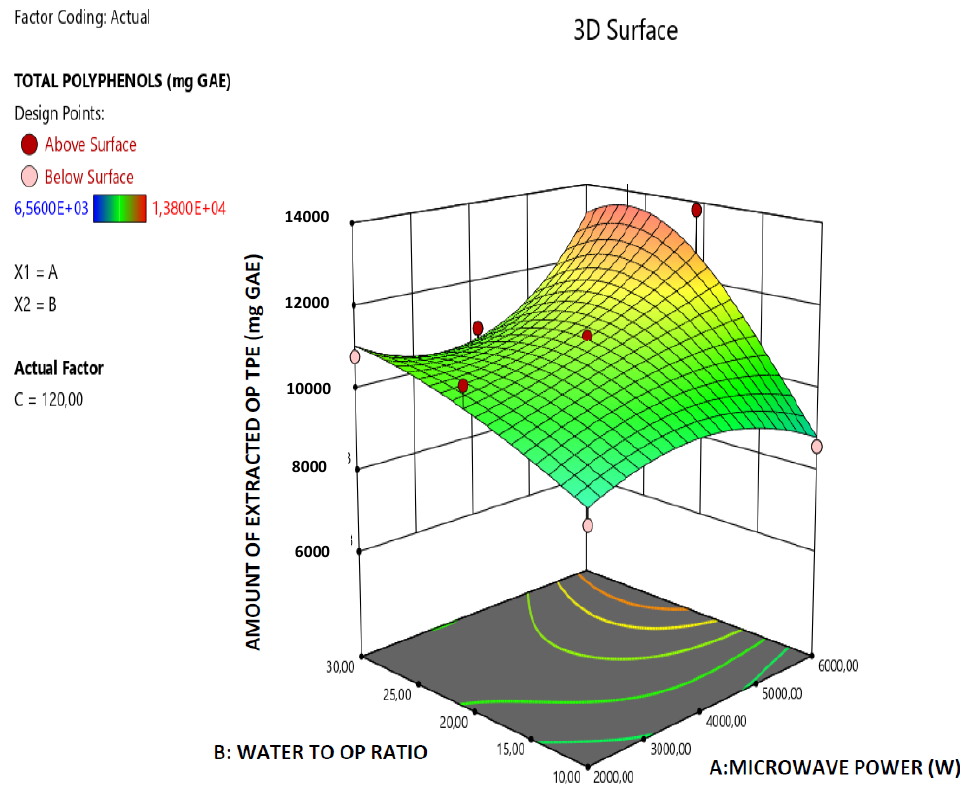
Figure 2. Response surface plot of the amount of extracted total OP polyphenols (TPE in mg GAE) A × B interaction (A: Microwave Power (W); B: water/OP ratio).